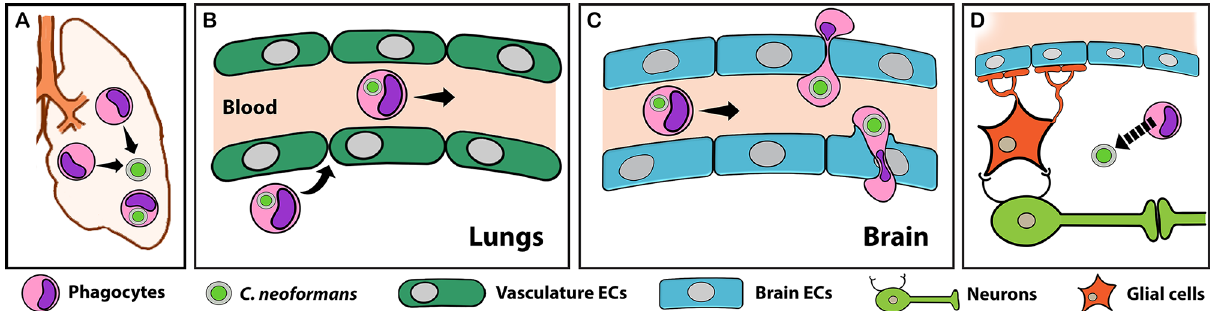
Fig 1. The role of phagocytes as Trojan horses for CNS pathogens. Most neuroinvasive pathogens first infect organsoutside the CNS, such as the lungs or the intestines. Cryptococcus neoformans infectionof the lungs is shown here as an example.Once infectionis established, phagocytes(pink cells) are recruited to these sites (A), where they engulf the pathogen.Some infected phagocytesleave the site of infectionand enter the bloodstream, facilitatedby the highly permeablevasculature (green) of peripheral organs (B). Through a process that is poorly understood, many of these home to the CNS. Once there, infected phagocytesmay act as Trojan horses, traversing the BBB (blue cells) with the pathogenas a passenger(C). Althoughboth paracellular(top) and transcellular (bottom) transmigration can occur, the latter is most likely due to the presenceof tight junctionsin the BBB (C). Once insidethe brain, pathogenscan potentially exit their Trojan horses and infect other neuralstructures (D). Parts of this model (A and B) also apply to phagocyte-assisted dissemination and infection outsideof the CNS (see text). BBB, blood–brain barrier; CNS, central nervoussystem; ECs, endothelialcells. Arrows indicate movement; brokenarrow indicatesfungal